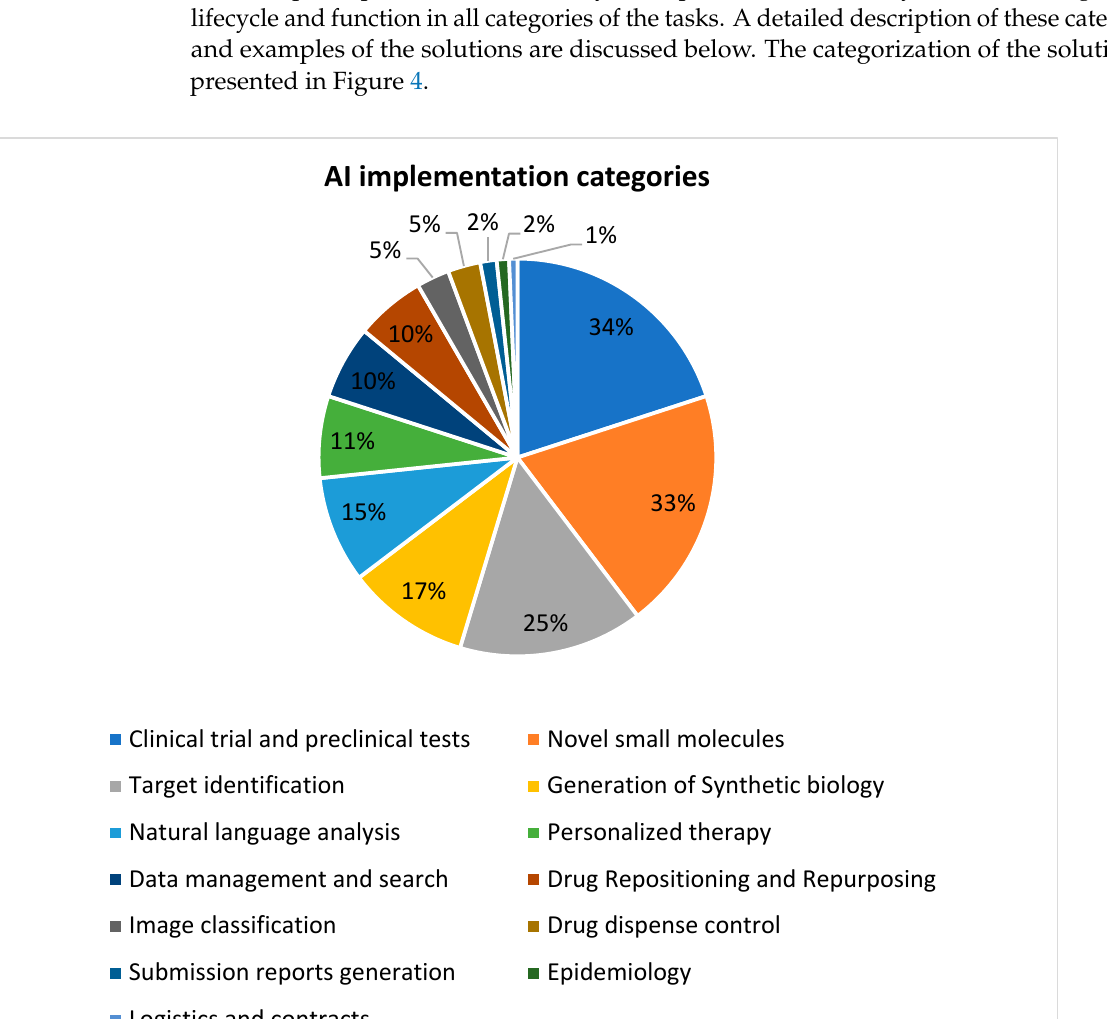
Figure 4. AI implementation categories.